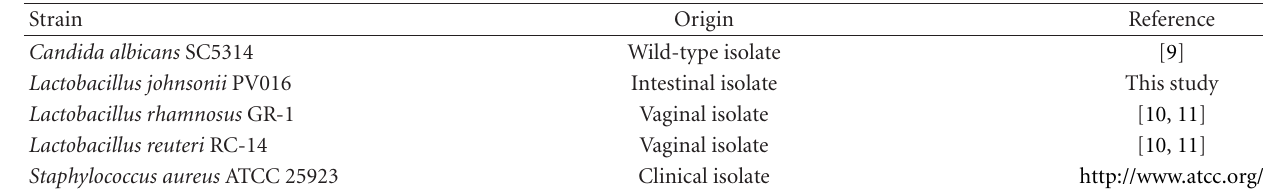
Table 1: Bacterial and Candida albicans strains used in this